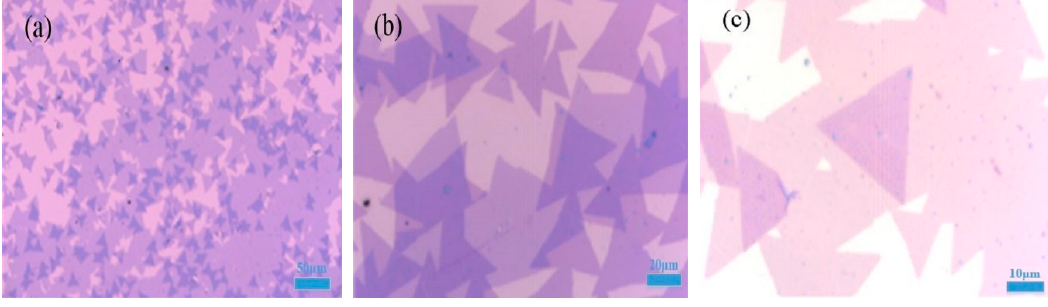
Figure 2. Optical microscopy images of MoS 2 /WS 2 vertical hetero-junction at different magnifications ( a ) 10 × ; ( b ) 50 × ; ( c ) 100 ×